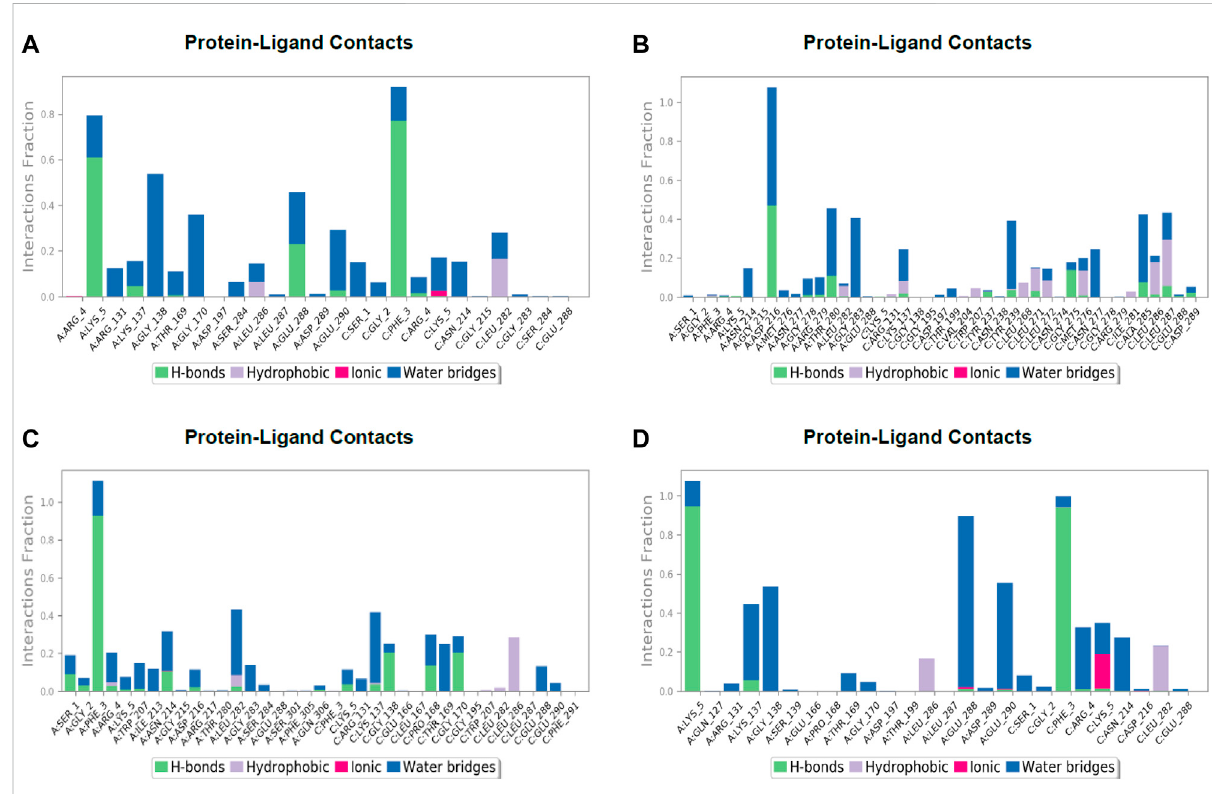
FIGURE 7 Post simulation analysis of protein – ligand interaction mapping. (A) Lonchocarpol A – 3CLPro complex, (B) broussonol E – CLPro complex, (C) diplacol – 3CLPro, (D) dexamethasone –